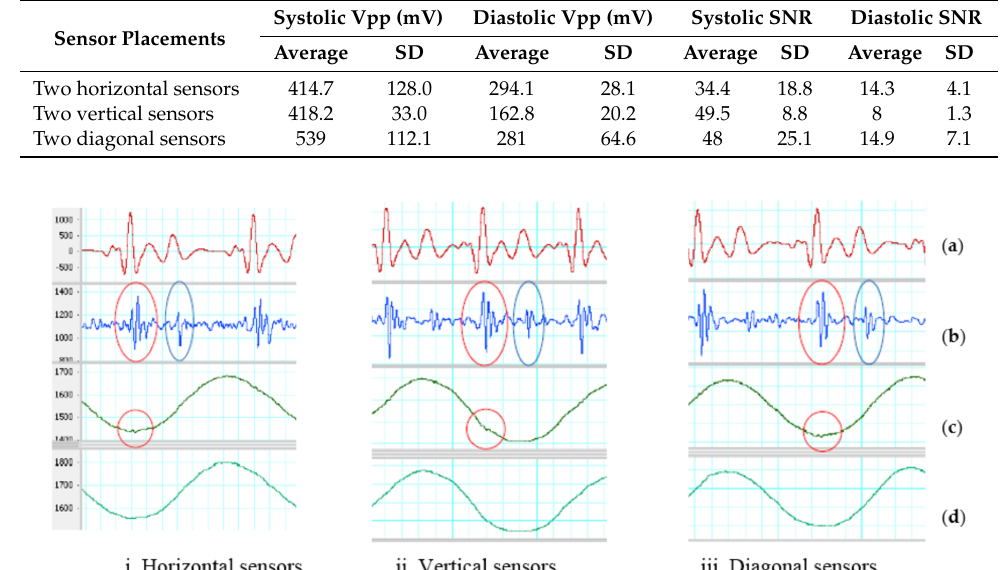
Table 1. Signal measurements of using two sensors with SUBTRACTOR on gentle motion.